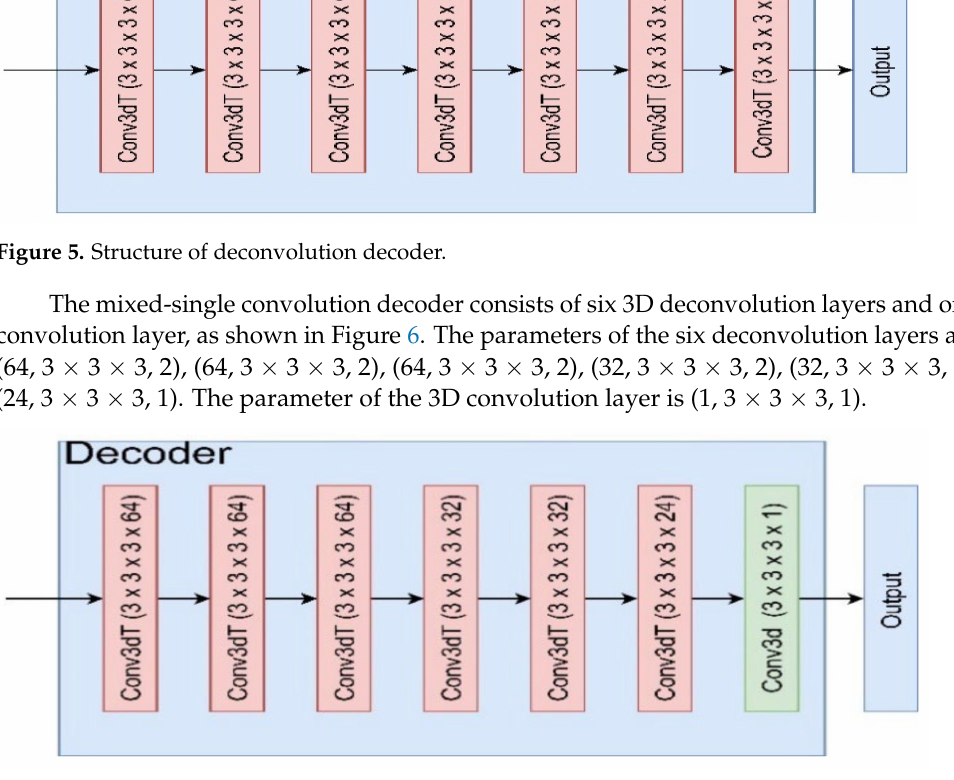
Figure 6. Structure of mixed-single convolution